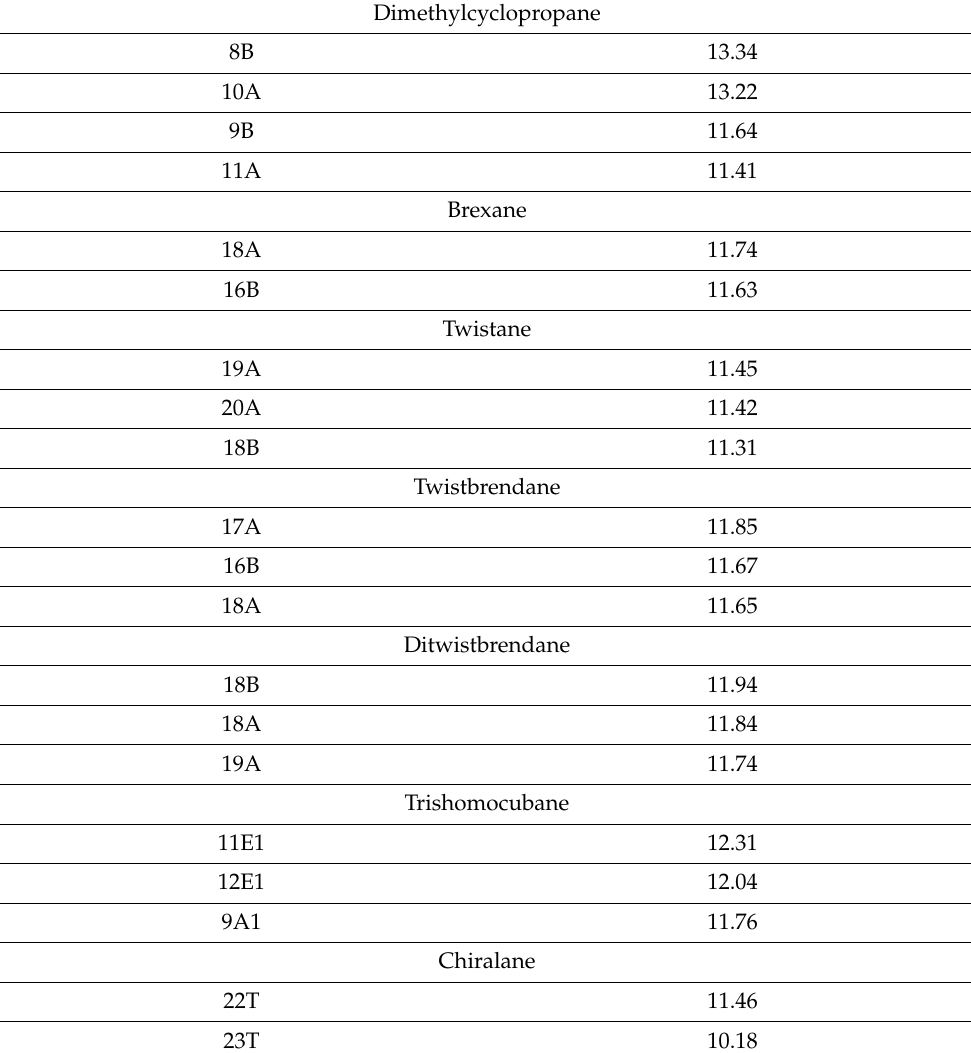
Table 1. Orbital ionizations and ionization energies from LB94 DFT